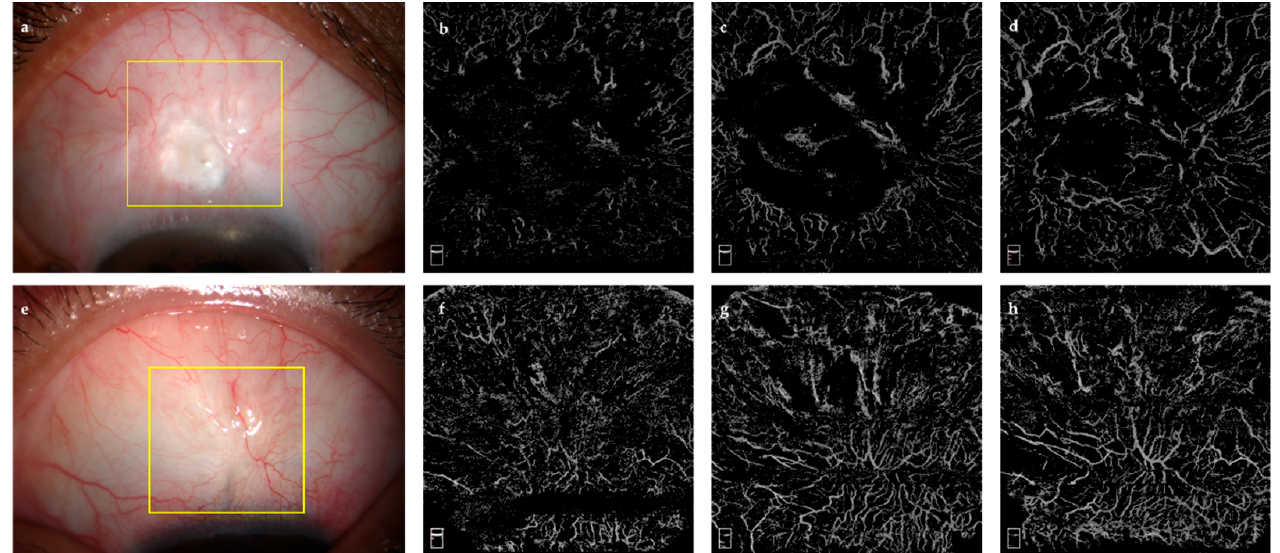
Figure 4. Cases showing anterior segment photographs and AS-OCTA images. ( a ) anterior segment photograph of success group; ( b – d ) superficial, Tenon’s, and deep-layer vessel flow image of success group; ( e ) anterior segment photograph of failure group; ( f – h ) superficial, Tenon’s, and deep-layer vessel flow image of failure group. Table 2. Vasculature parameters in bleb area between success and failure